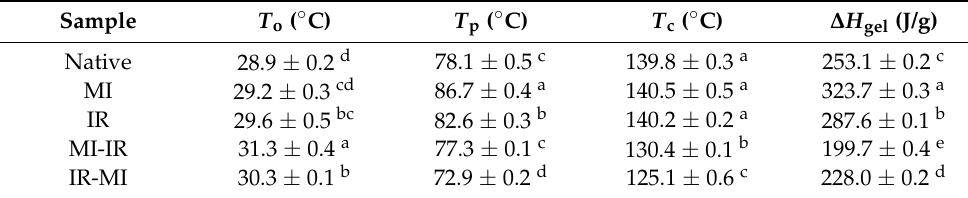
Table 3. Thermal properties of native and modified lotus rhizome starches.